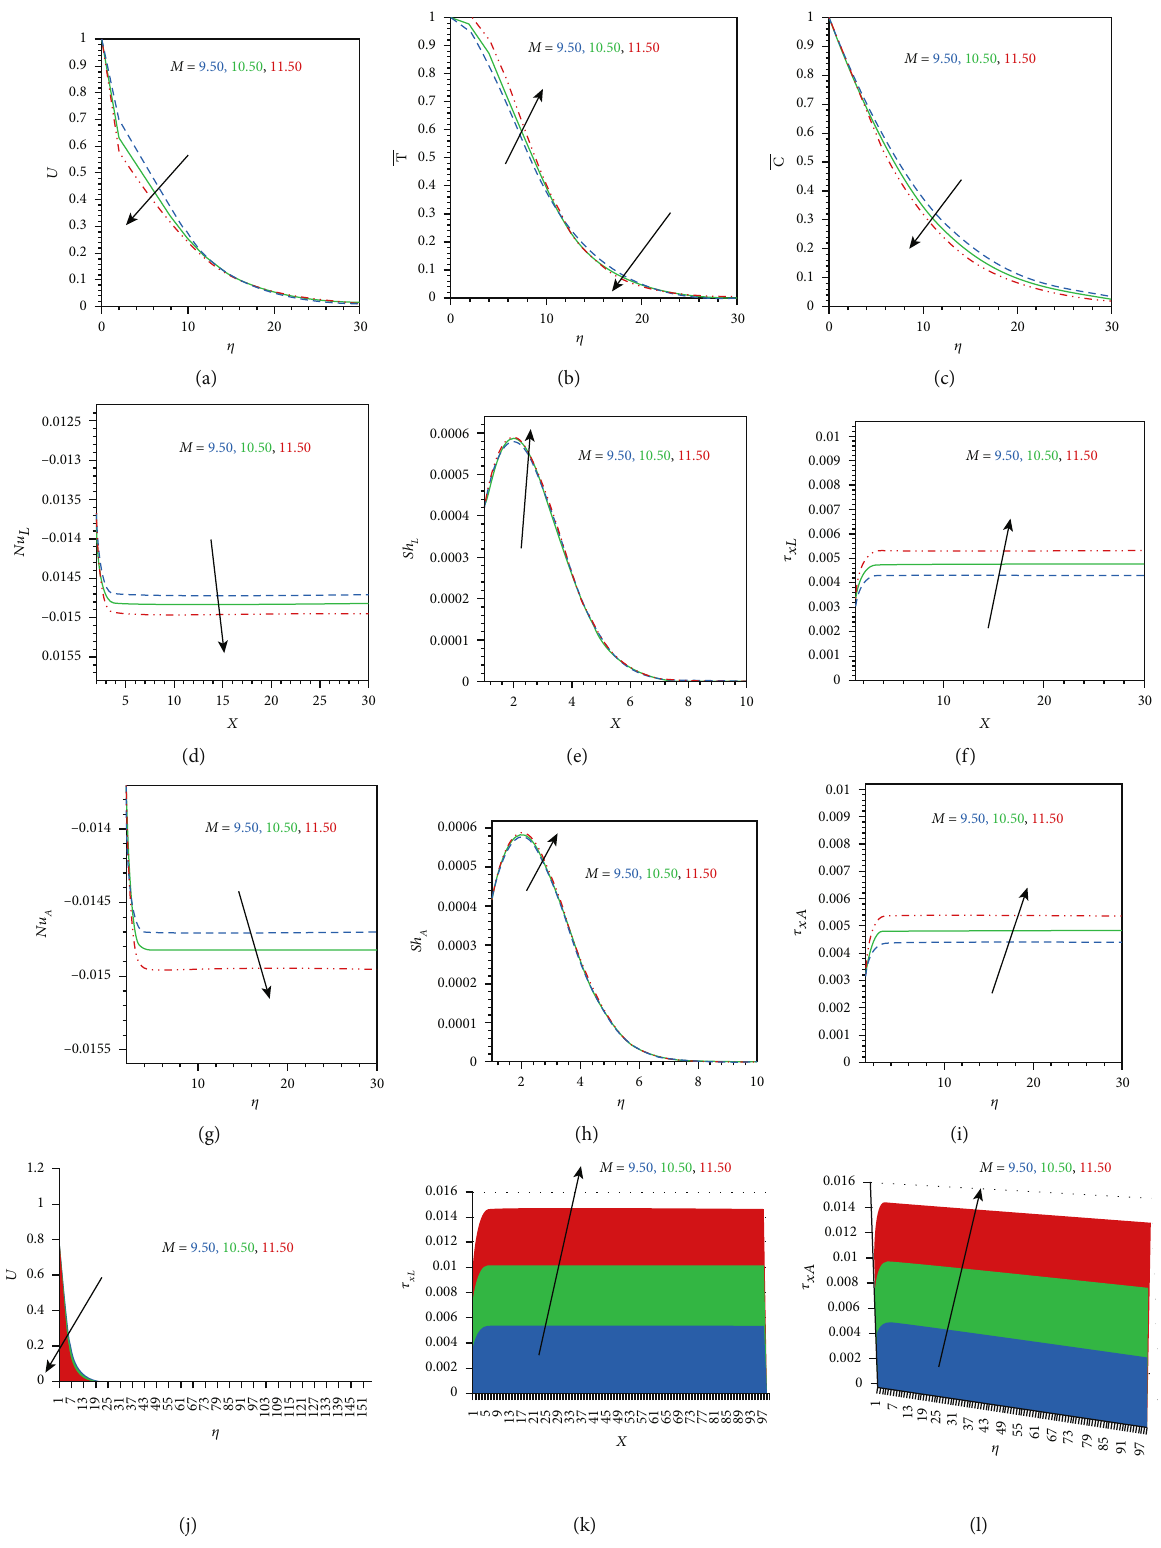
Figure 7: In fl uence of magnetic fi eld on (a) fl ow, (b) thermal, (c) material fi elds, (d) Nu fi elds, (k) τ , and (l) τ in 3D plot with Gr = 3 : 5 , Gm = 4 : 5 , Pr = 1 , Ec = 0 : 1 , Sc = 0 : 22 , N = 1 , R = 1 , and H = 0 : 3 xL xA